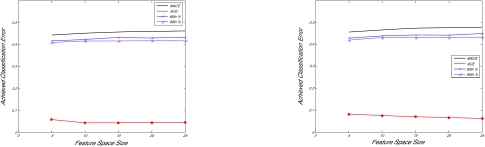
PACE analysis using a SVM-based classifier using the simple separability scoring criterion, with a 0.6 MAC threshold. Left Panel: performance without peak selection. Right panel: performance with peak selection.